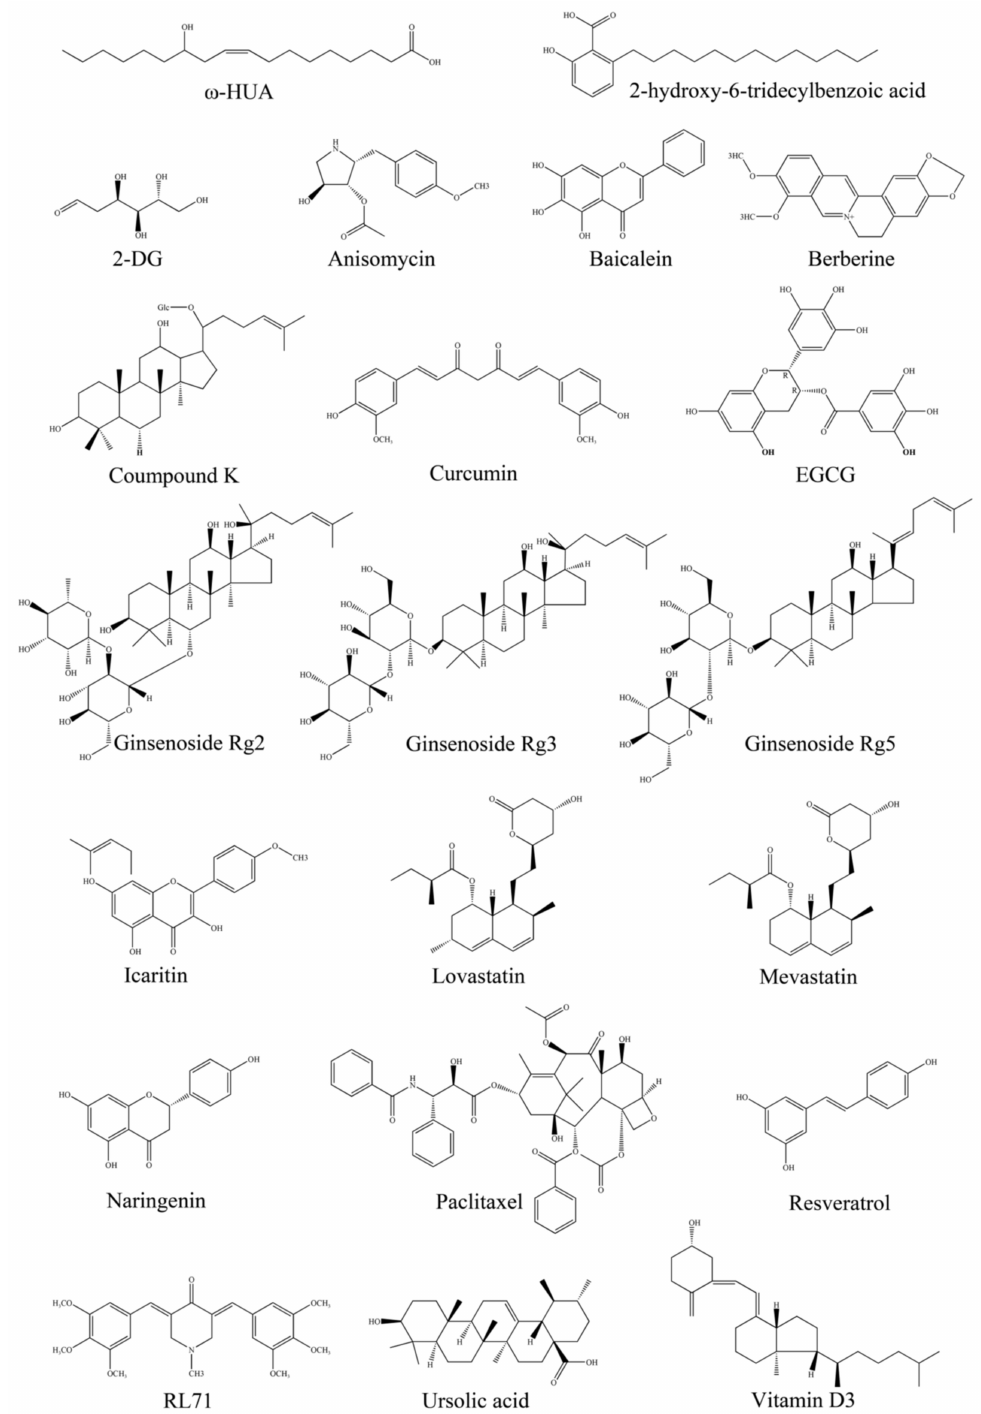
Figure 4. Chemical structures of natural products from herbal medicines used as potential AMPK modulators. ω -HUA: ω -hydroxyundec-9-enoic acid; 2-DG: 2-deoxy-D-glucose; EGCG: ( − )- Epigallocatechin-3-gallate; RL71: curcumin